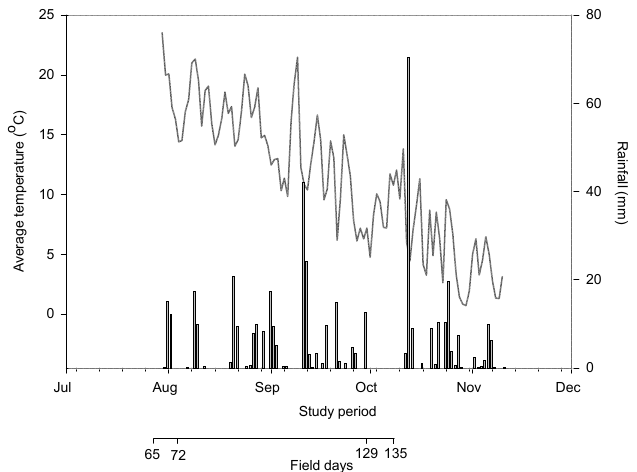
Figure 2. Mean average temperature (°C, solid line) and rainfall (mm, vertical bars) during the study period.